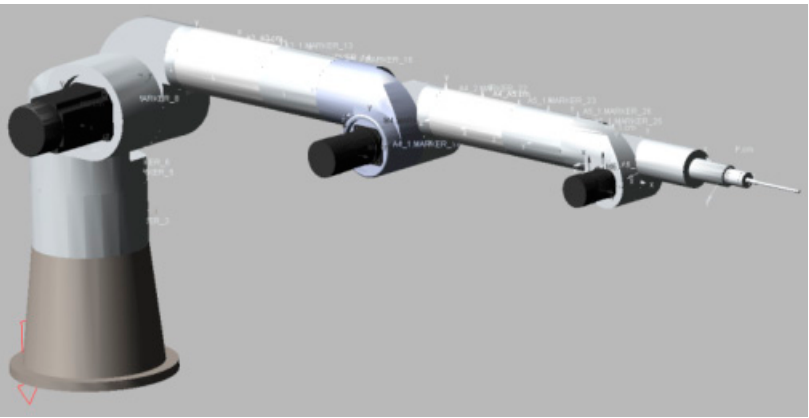
Figure 5. 3D model imported in MSC Adams View.